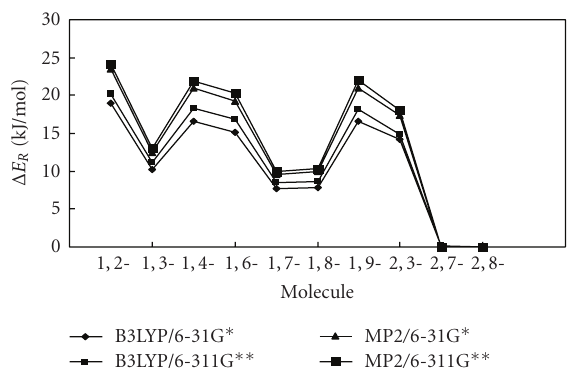
Figure 2: The change tendency of Δ E for Di-PZs at di ff erent